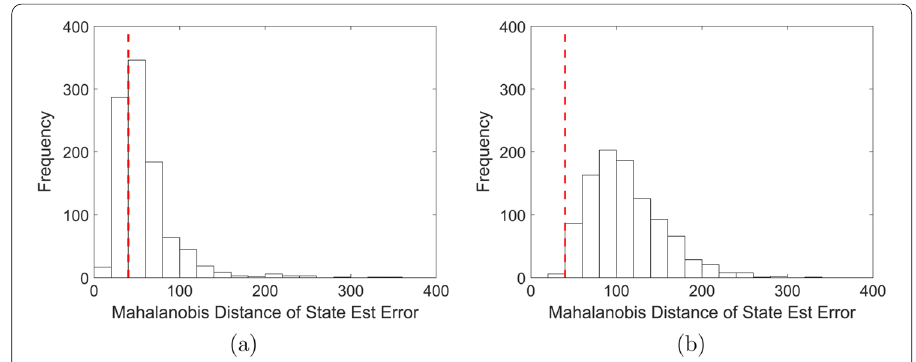
Fig. 7 Mahalanobis localization errors for linear motion. Vertical dashed line is the true mean 2 n = 40 . Based on variance estimates from a proposed method and b ML method